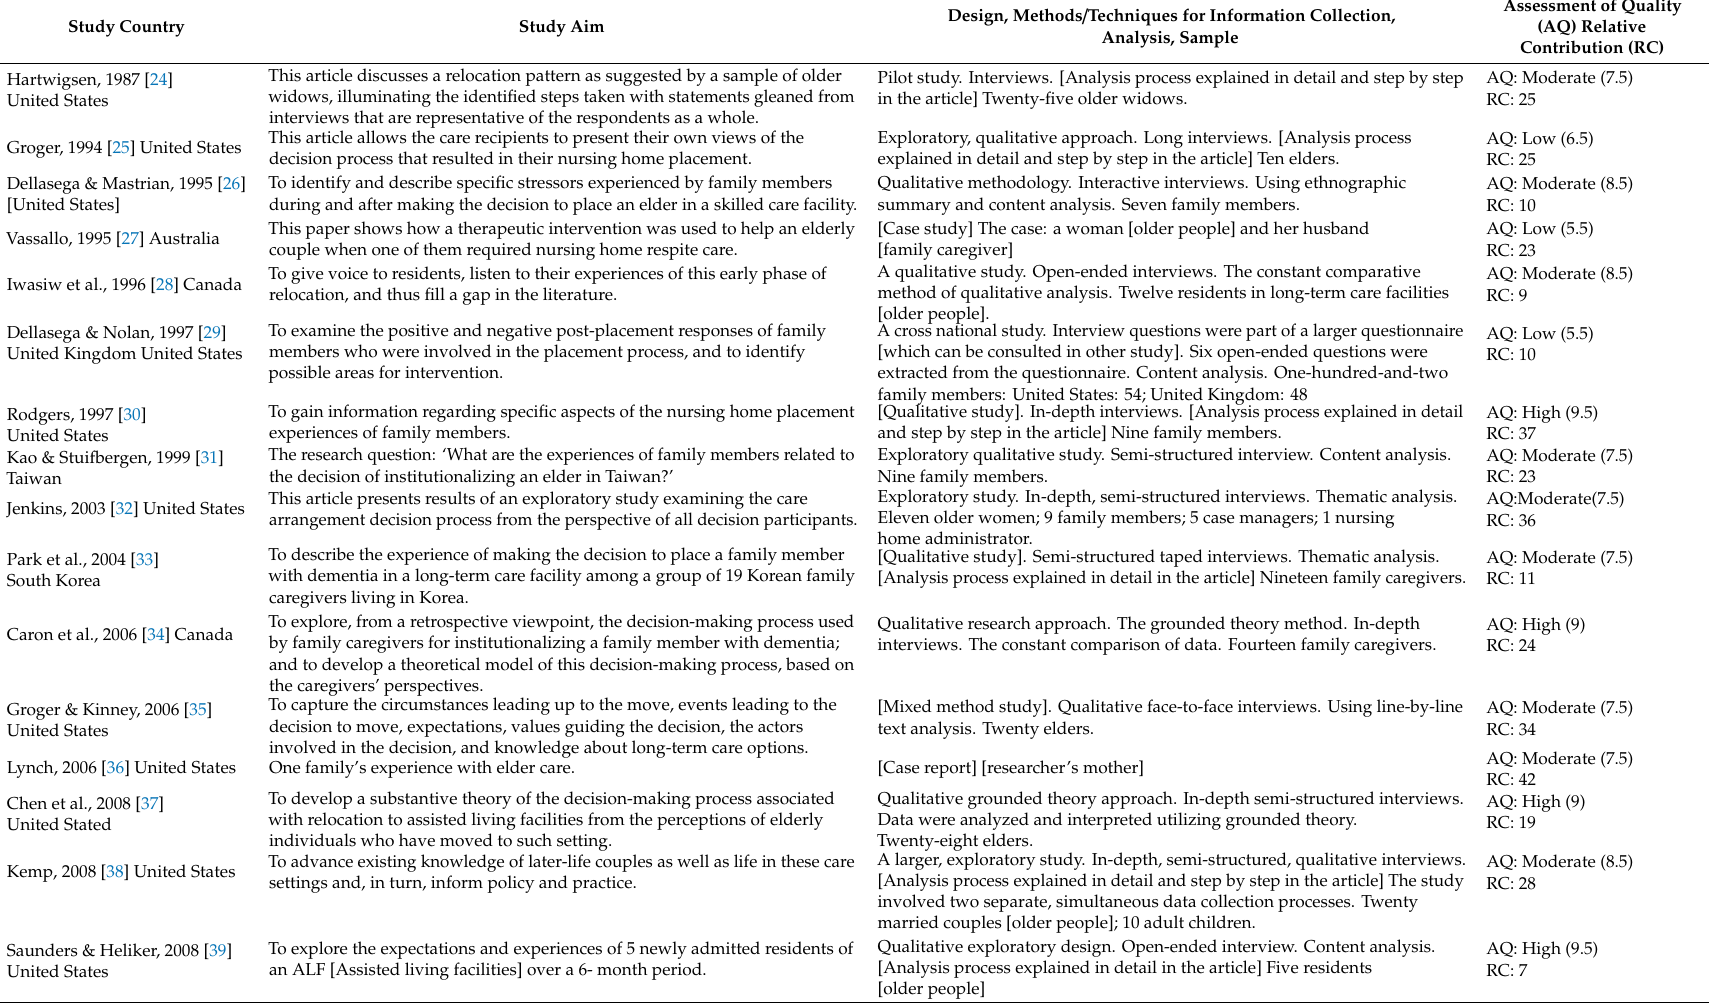
Table 1. Characteristics of the included studies, quality assessment and relative contributions (a)